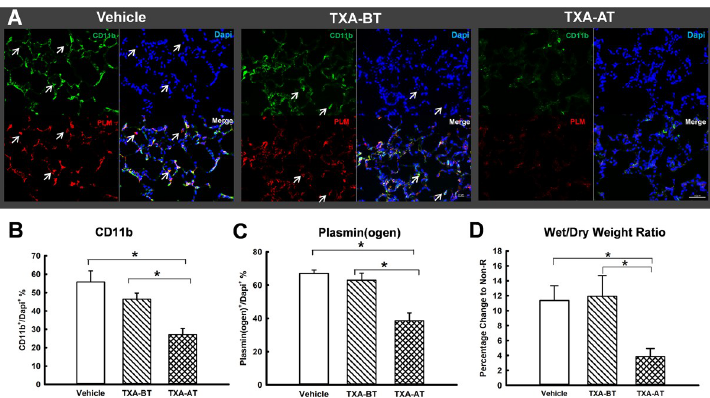
Fig 5. Acute lung injury. (A) Immunohistochemistry staining of CD11b and plasminogen (n = 6 per group); (B) CD11b + %; (C) plasmin(ogen) + %: � ((B) and (C)): significant difference compared to Vehicle and TXA-BT; arrow sign of (A) indicates cell in the alveoli with co-localized stain of CD11b, plasmin(ogen) (PLM) and DAPI. (D) Lung wet/dry weight ratio (n = 10 per group). The dot line was presented as the range of lung wet/dry ratio from the rats without resuscitation [22]. � : significant difference compared to Vehicle and TXA-BT.